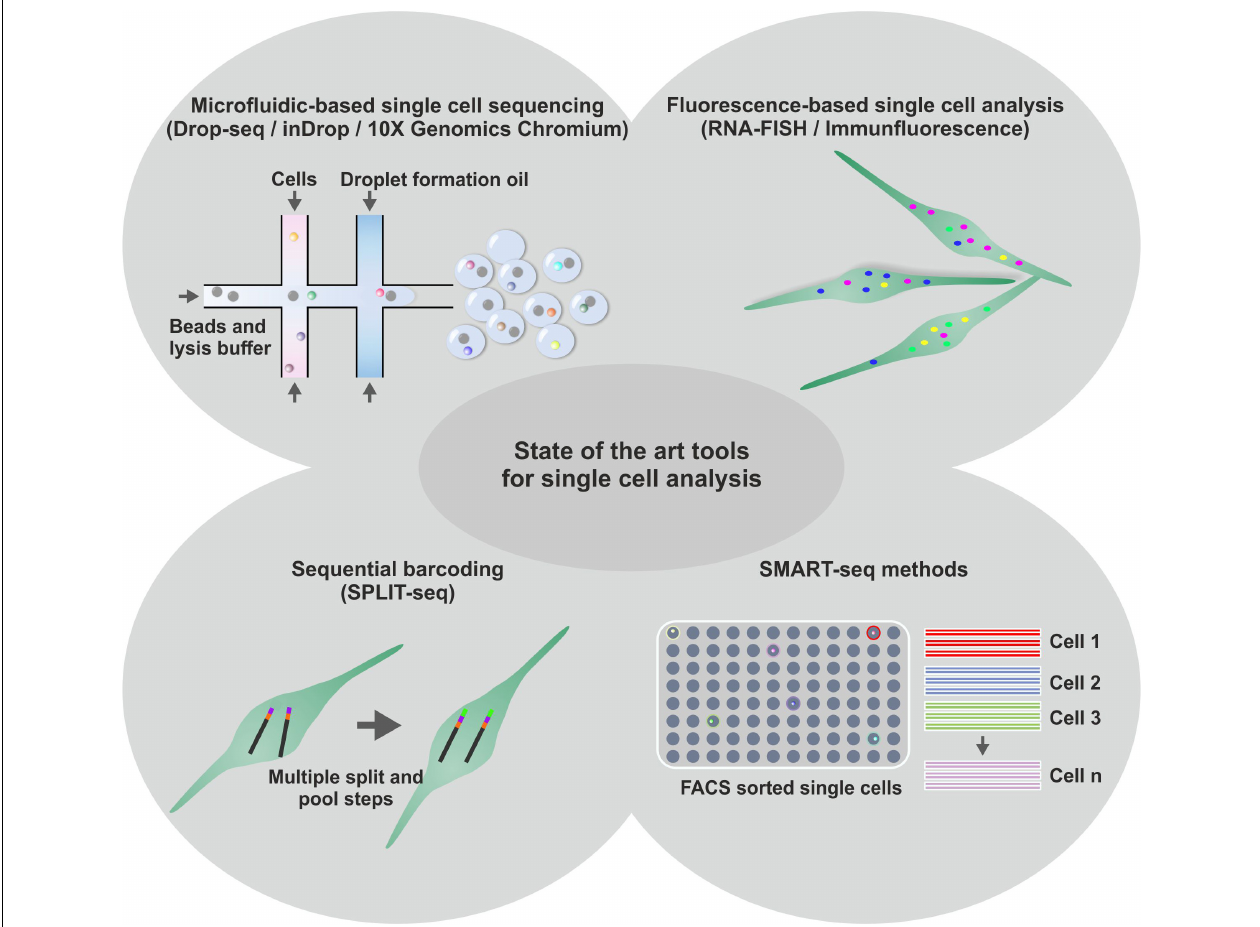
FIGURE 2 | Schematic representation of diverse state-of-the-art tools for single cell analysis. Next to microfluidic based single cell sequencing methods, like Drop-seq, inDrop or 10X Genomic Chromium, for high throughput transcriptome analysis of single cells, fluorescence-based methods are used to investigate single cell transcriptomes. Further, Sequential barcoding methods like SPLIT-seq are applied for high throughput single cell sequencing. Less throughput, but higher precision was shown to be achieved using SMART-Seq methods with prior fluorescence activated cell sorting (FACS).